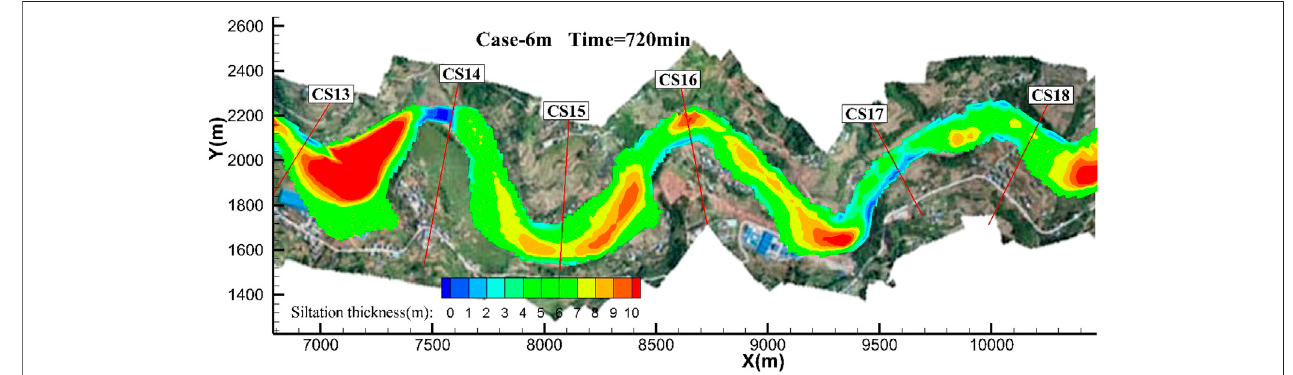
FIGURE 12 | Siltation distribution downstream the Zhongdu